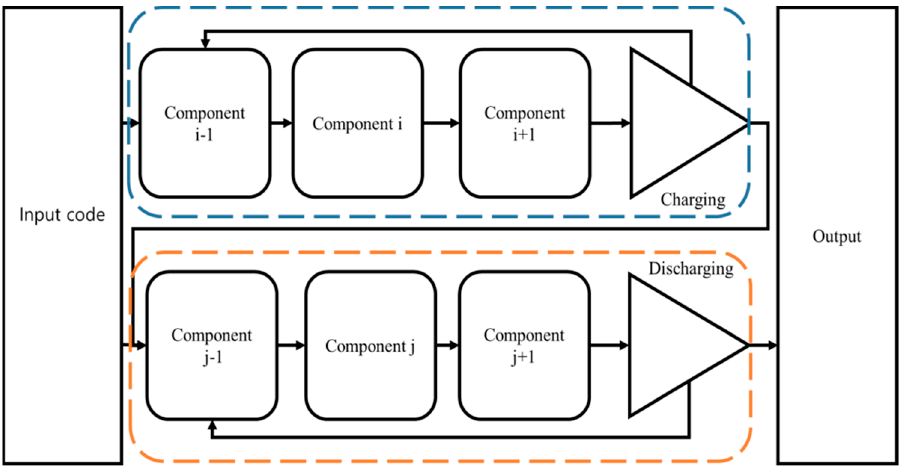
Figure 2. Overall algorithm structure of the KAIST-CCD code. Table 1. Parameters for LAES Calculation data from [15].